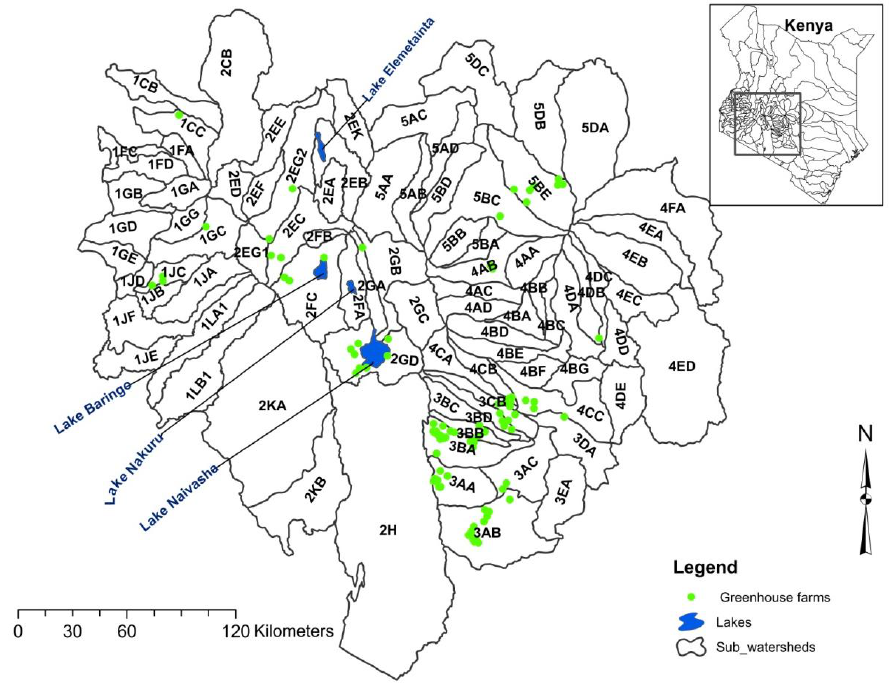
Figure 1. Study area. ( a ) Map of Kenya (right), and inset (left) is the study area showing sub-watersheds in the central highlands considered in the study. ( b ) Major towns, rivers, lakes and mountain features—Mt. Kenya and the Aberdare ranges; ( c ) A Google Earth image of a greenhouse and a